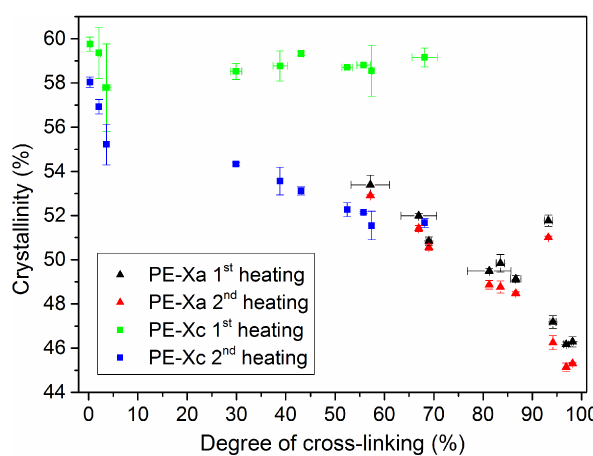
Figure 5. Crystallinity of PE-Xa and PE-Xc samples measured with